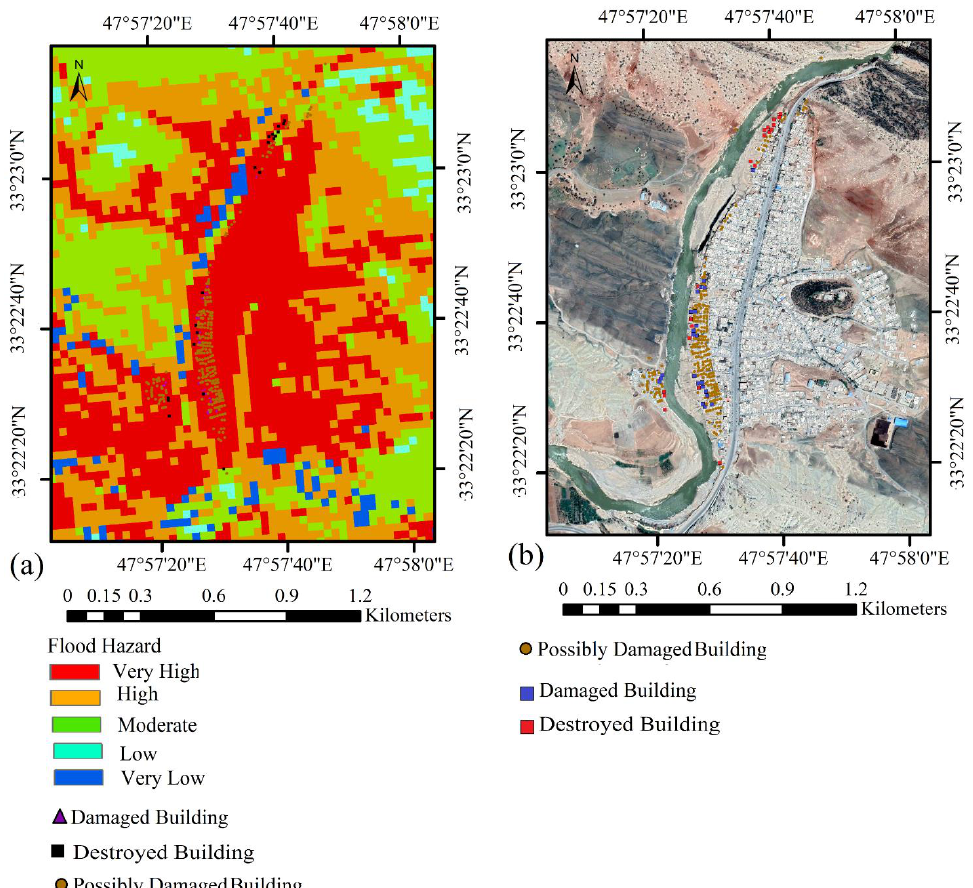
Figure 9. Buildings/Properties which were affected by the flood event in Mamulan in April 2020: ( a ) the flood hazard map in Mamulan produced using the proposed method, ( b ) Aerial photo of the affected areas in Mamulan during flood on April 2020 using CEMS reports. Remote Sens. 2021 , 13 , x FOR PEER REVIEW